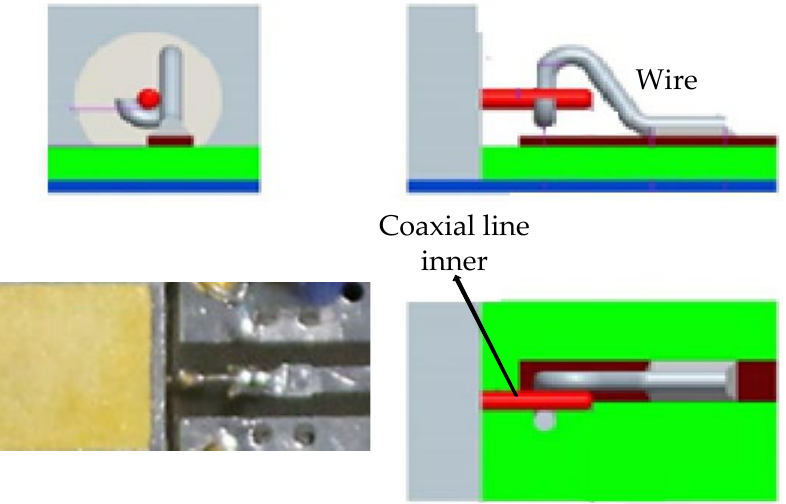
Figure 3. Wire winding soldering structure.